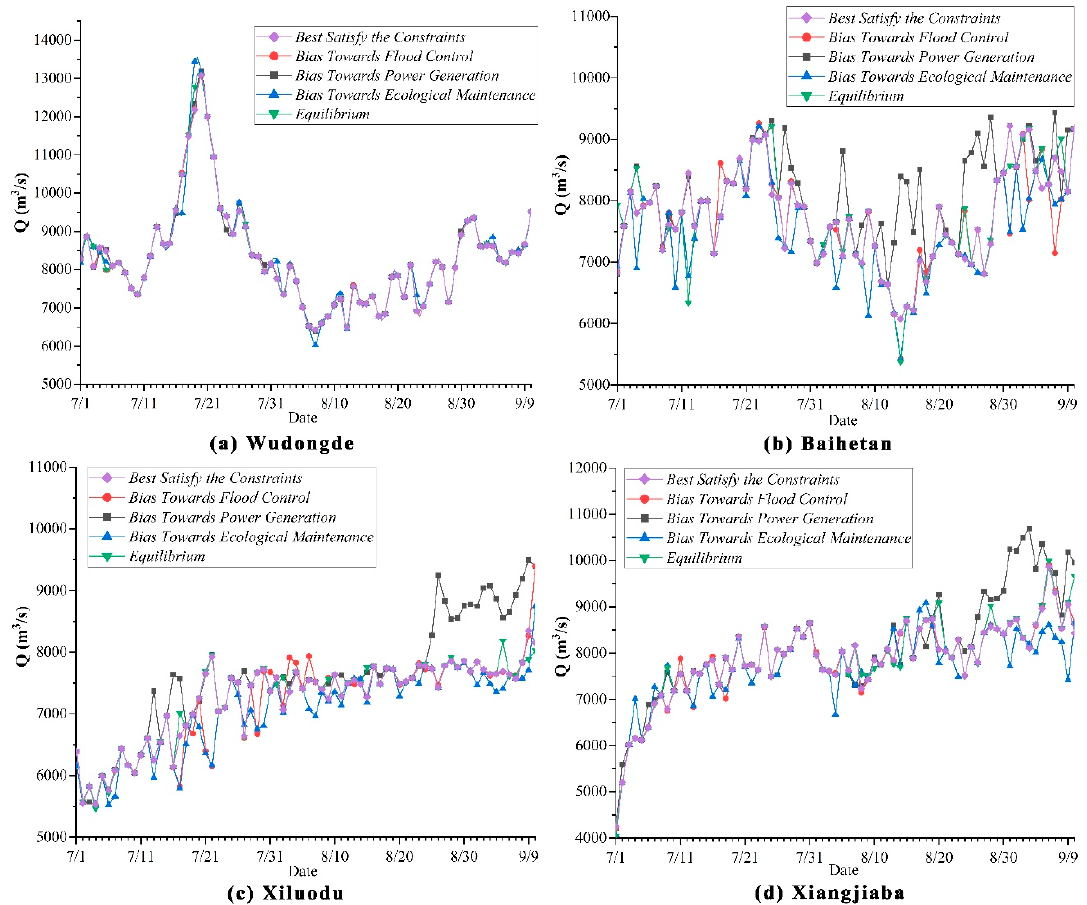
Figure 9. The cascade dispatching process downstream of the Jinsha River under the typical schemes.